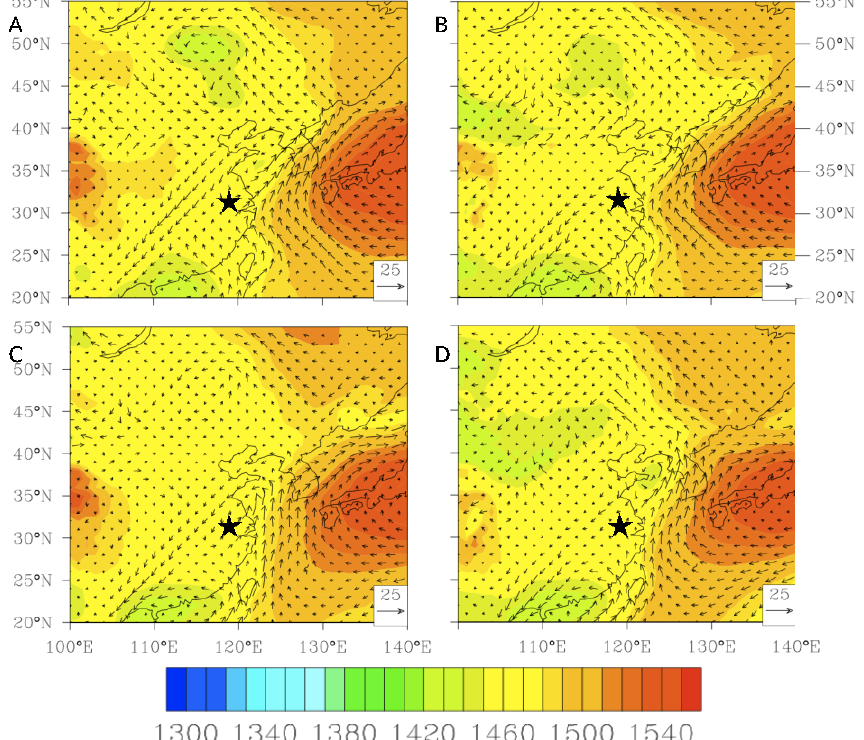
Figure 5. Geopotential height maps over East Asia at the 850 hPa level from National Centers for Environmental Prediction and National Centers for Atmospheric Research (NCEP/NCAR) reanalysis data. The dates and times are ( A ) 13 July 2011, 0:00 UT, ( B ) 13 July 2011, 12:00 UT, ( C ) 14 July 2011, 0:00 UT, ( D ) 14 July 2011, 12:00 UT. The star (  ) indicates the location of